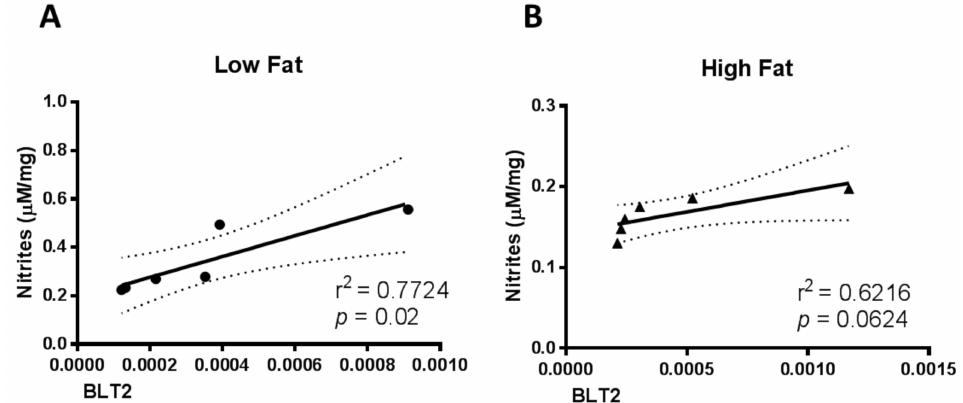
Figure 2. The NO levels positively correlate with BLT2 expression levels in low fat diet mice. Correlation between nitrites and BLT2 mRNA levels in skin from; ( A ) low fat diet mice; and ( B ) high fat diet mice. n = 6 per